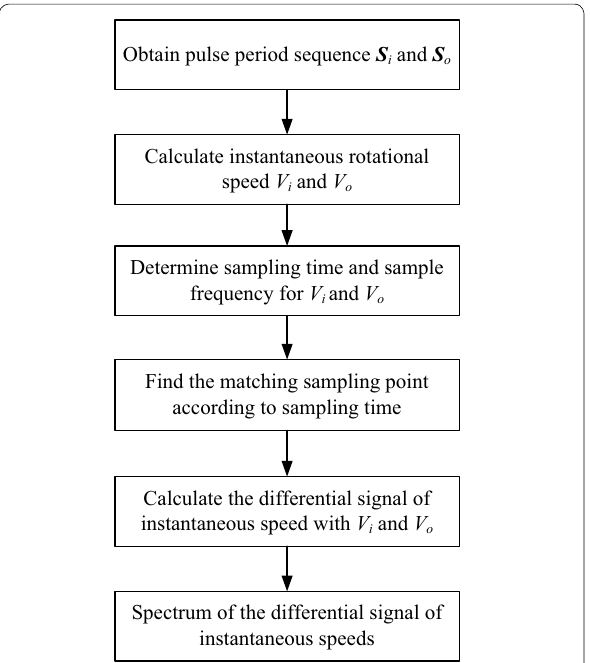
Figure 3 Feature extraction scheme